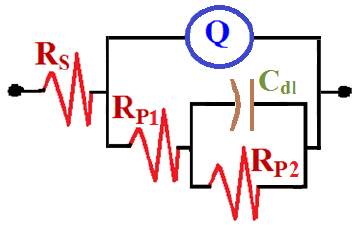
Figure 8. Equivalent circuit model that fits the EIS experimental data.